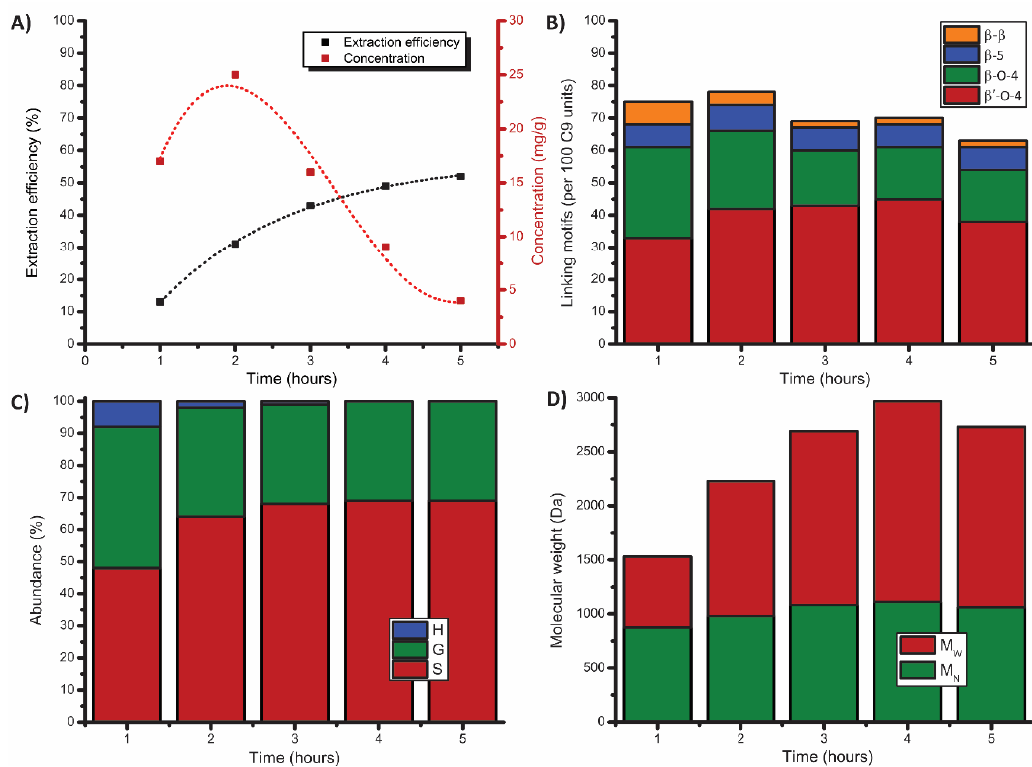
Figure 3. Results of the mild organosolv extraction (80:20 EtOH/H 2 O, 0.18 M H 2 SO 4, 120 °C, 5 h), showing ( A ) extraction efficiency (corrected for alcohol incorporation as determined by 2D HSQC) and lignin concentration, ( B ) linking motifs distribution and ( C ) H/G/S ratio as determined by 2D HSQC, and ( D ) molecular weight distribution as determined by GPC (THF).